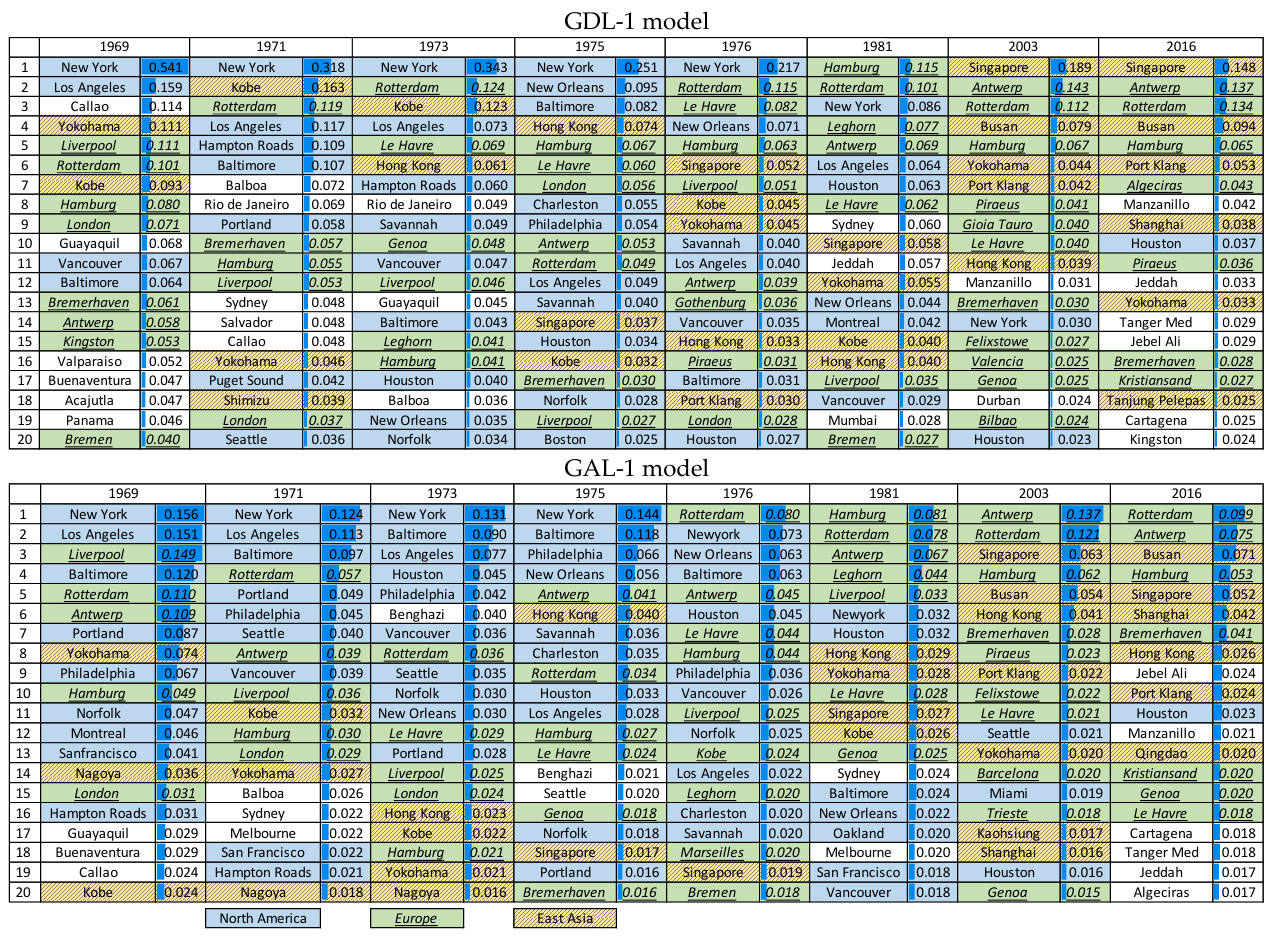
Figure 4. Top 20 ports in betweenness centrality and their scores estimated from the GDL-1 and GAL-1 models (1969–2016).